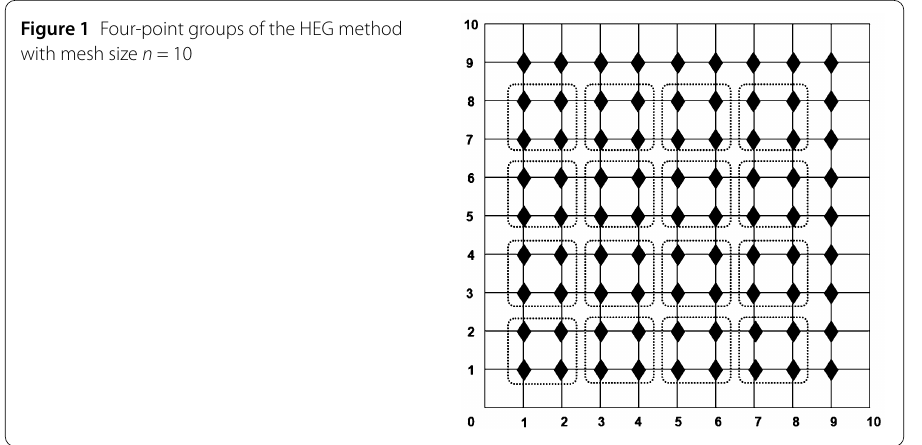
Figure 1 Four-point groups of the HEG method with mesh size n =